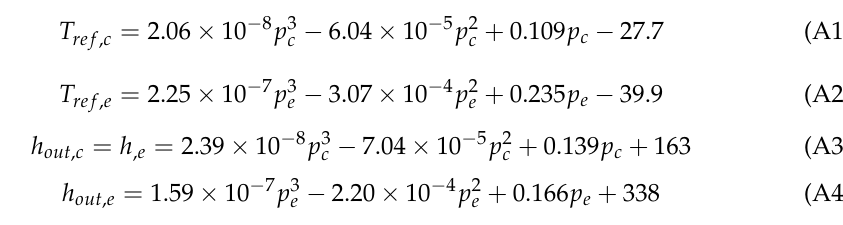
The curve fits created for the refrigerant thermodynamic properties are in Section